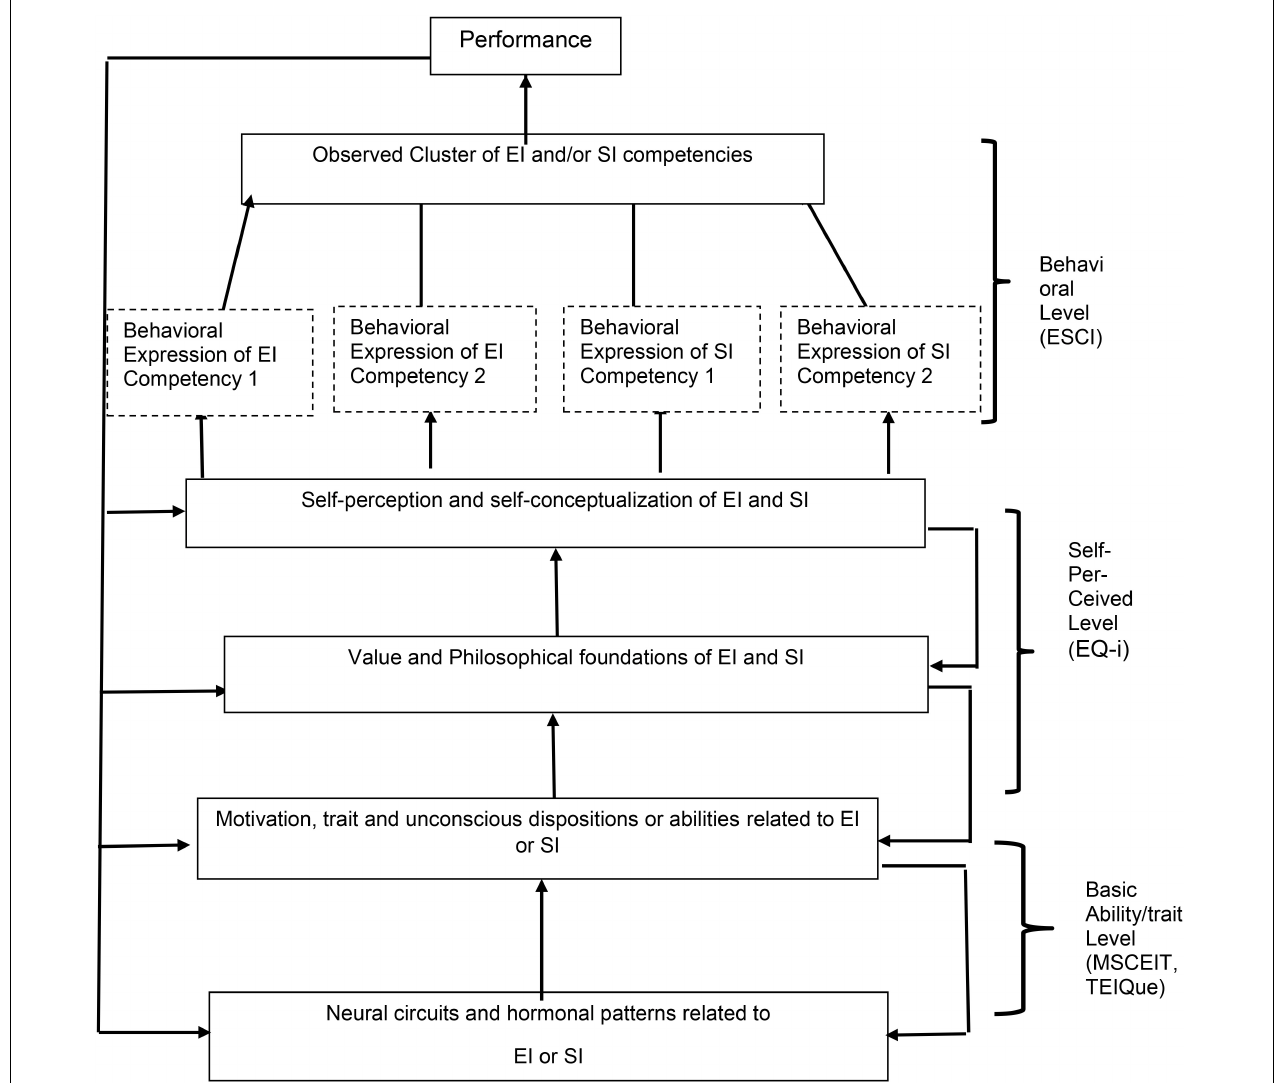
FIGURE 1 | Emotional intelligence (EI) as a multi-level theory [from Cherniss and Boyatzis (2013) which was adapted from Boyatzis (1982, 2009)].